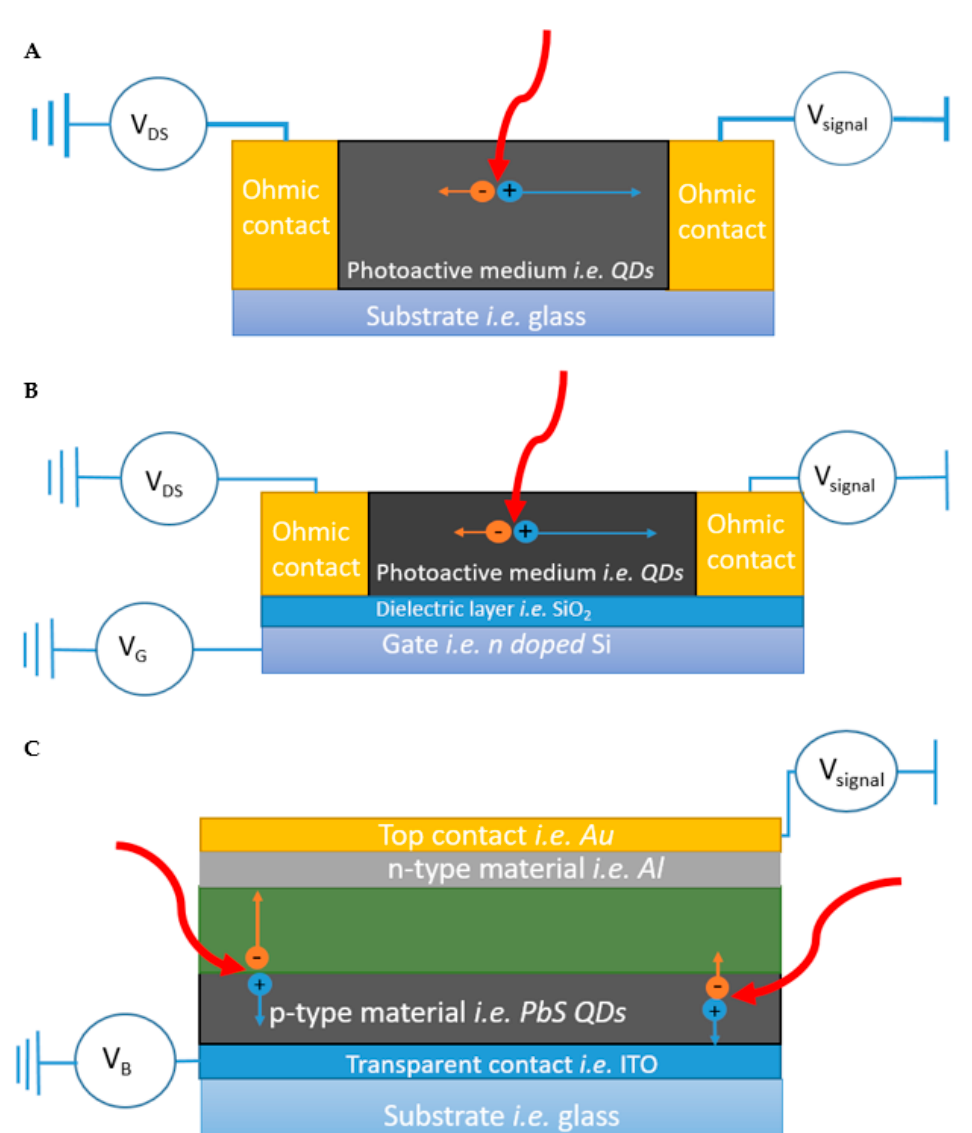
Figure 3. ( A ) Schematic of a photoconductor device. Incident photons [thick red curved arrows] cause electron-hole pairs to form within the photoactive region [black]. A constant applied voltage [ V DS ] causes electrons [orange circles] and holes [blue circles] to traverse the photoactive region towards their respective electrodes at di ff erent speeds, indicated by the di ff erent lengths of orange and blue arrows (in this example holes are traveling faster). As hole are collected at the drain electrode, new holes are injected at the source electrode to maintain charge neutrality; as holes circulate through the device gain is achieved. ( B ) Schematic of a phototransistor device. Operation is similar to a photoconductor, but the device is fabricated on a substrate that allows for the possibility of applying a gate voltage [ V G ] to tune transport in the photoactive area. ( C ) Schematic of a photodiode device. A p - n junction enhances charge transport by creating an internal electric field. The green shaded region indicates the depletion region, which can be tuned by altering the bias voltage [ V B ]. Carriers generated in the depletion region are quickly separate and are collected, while carriers generated outside of the depletion region must avoid recombination while they di ff use to either depletion region or contact. All devices are displayed as having a current readout; this signal is typically converted into voltage by a load resistor for easy readout using an oscilloscope.